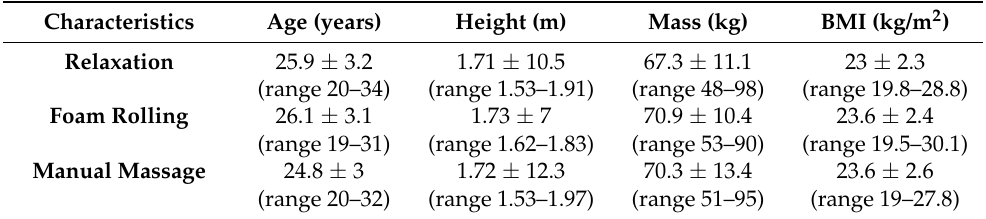
Table 1. Baseline characteristics (M ± SD). There were no adverse events and no subjects withdrew from the study. BMI: body mass index.